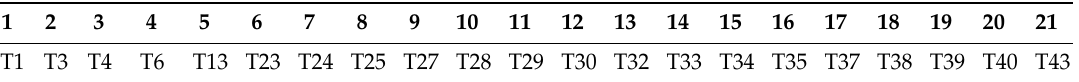
Table 1. Magdalena case study: partly confined reaches of the Magdalena river according to the River Styles analysis performed on the segmentation obtained with the proposed procedure in Nardini et al. [37,38].